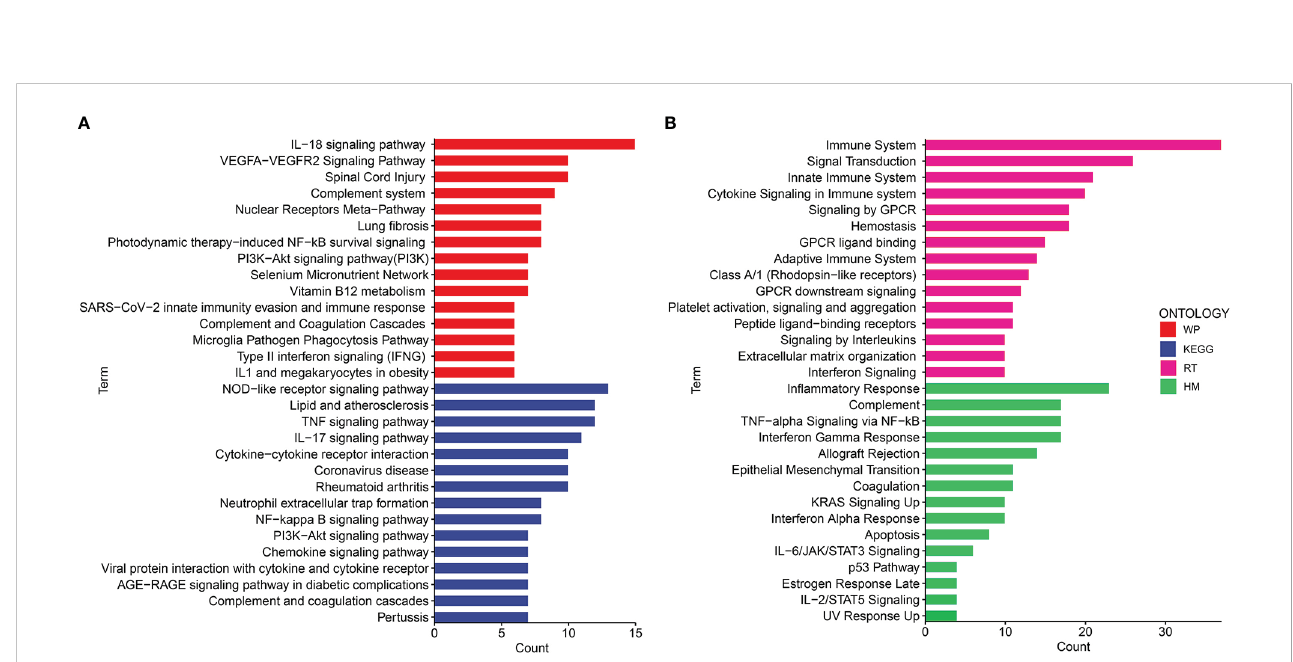
FIGURE 4 The bar graphs of the pathway enrichment analysis of the shared DEGs between COVID-19 and IBD. (A) WikiPathways and KEGG 2019 human Pathways (B) Biocarta pathways and